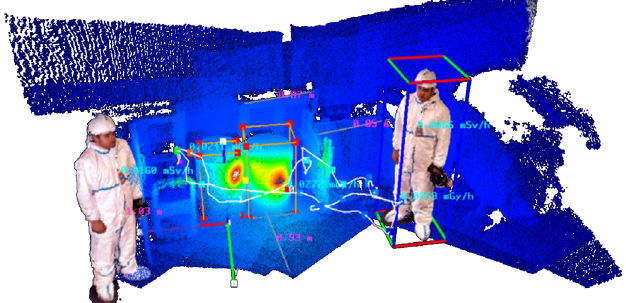
Fig. 11. Radioactive measurements 3D back-projection.